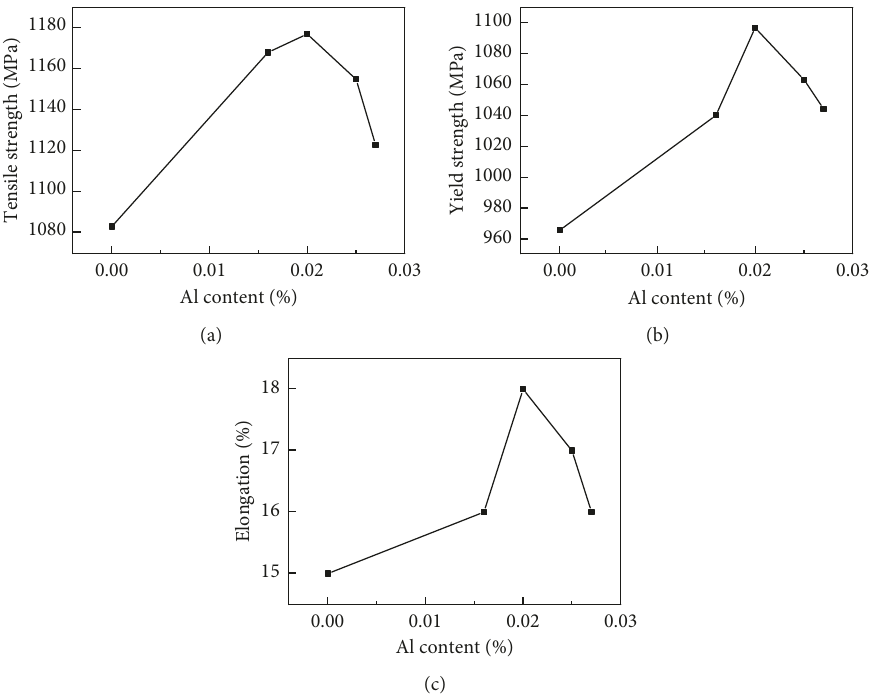
Figure 1: The evolutions of mechanical properties with the content of aluminum. (a) Tensile strength. (b) Yield strength. (c) Elongation after breakage.